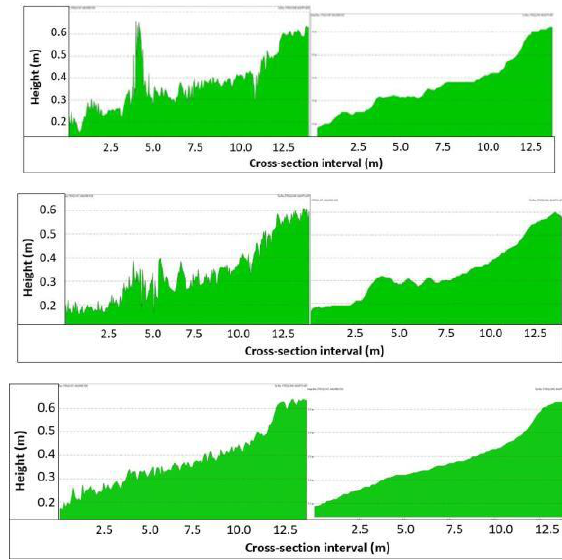
Figure 3. DSM (left) and DTM (right) profiles for the AT (top), DG (middle) and LiDAR (bottom) datasets of Epoch 3.